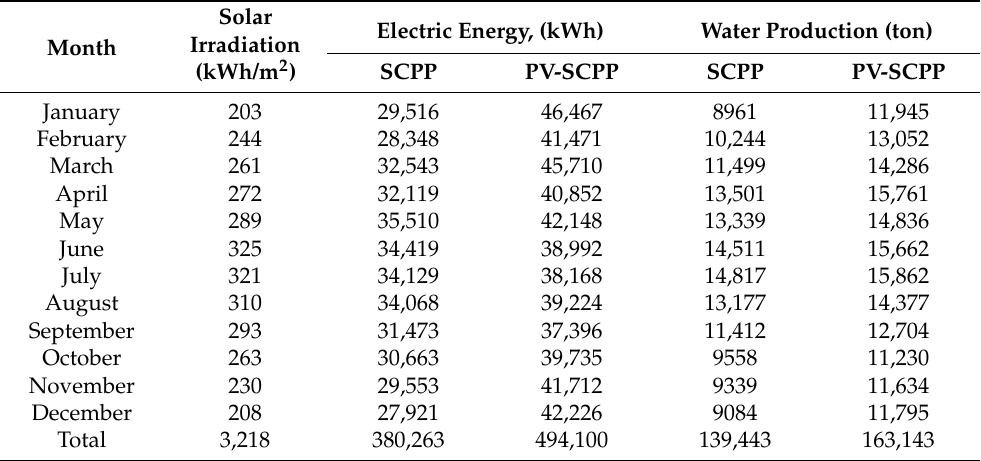
Table 3. SCPP monthly production of electricity and water with and without two-meter PV length integration.